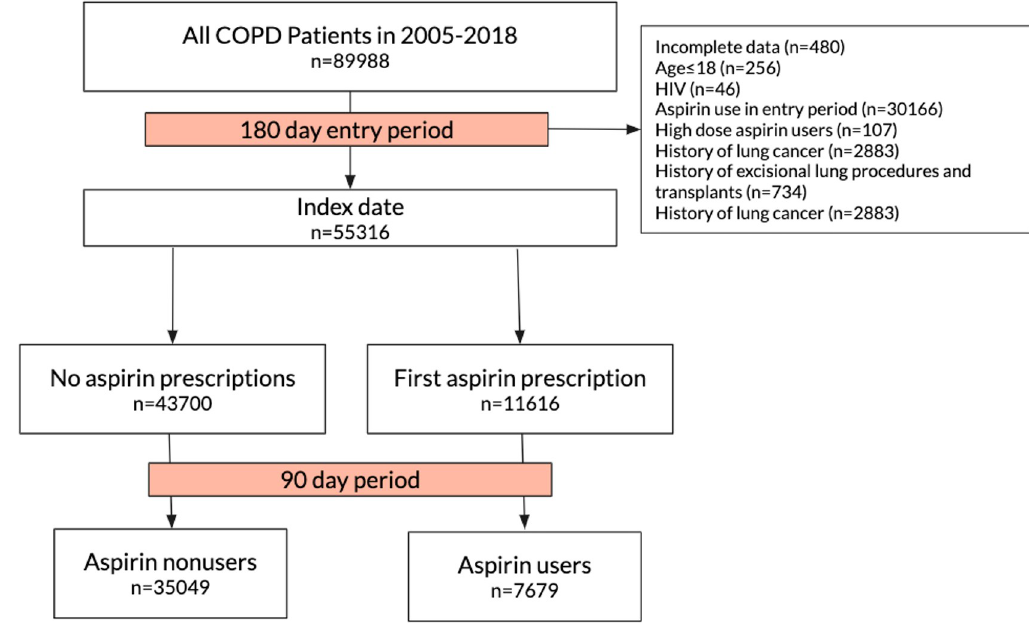
Fig 1. Study cohort selection flow diagram. Patients are excluded during the 90-day period if there are mortalities, diagnoses of lung cancer, excisional lung surgeries, or antiplatelets use other than aspirin. COPD, chronic obstructive pulmonary disease.